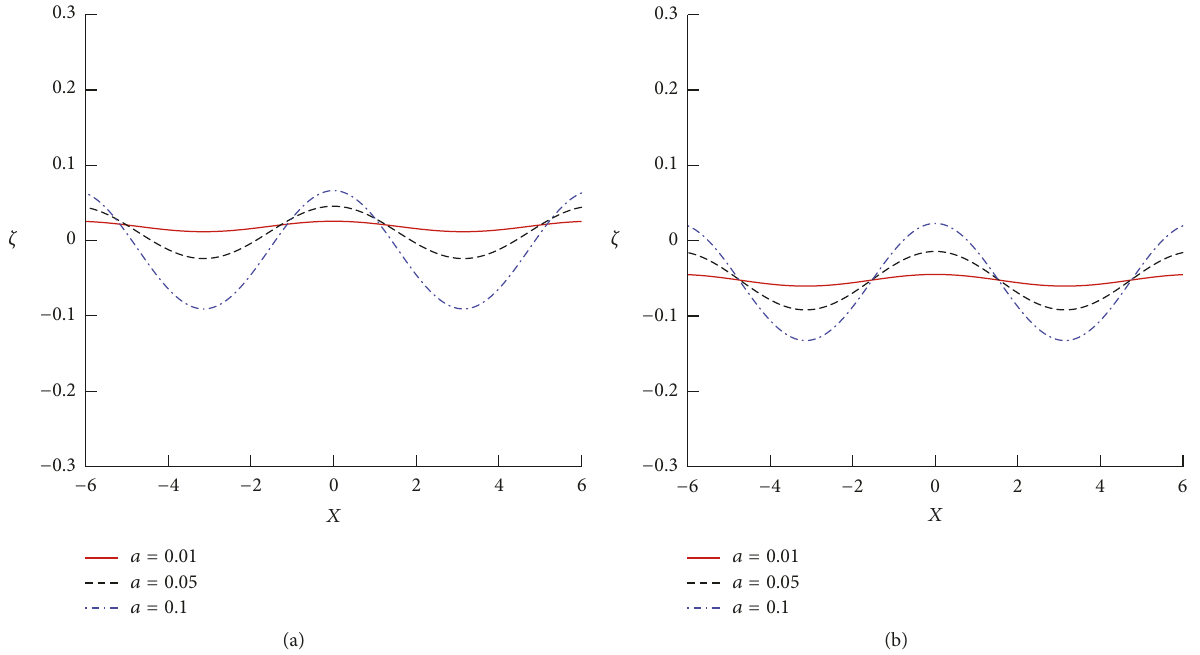
Figure 4: Variation of the plate hydroelastic deflection versus 𝑥 for different wave amplitude 𝑎 on a following current. (a) 𝑈 1,0 = 0.1 . (b) 𝑈 = 0.3 1,0